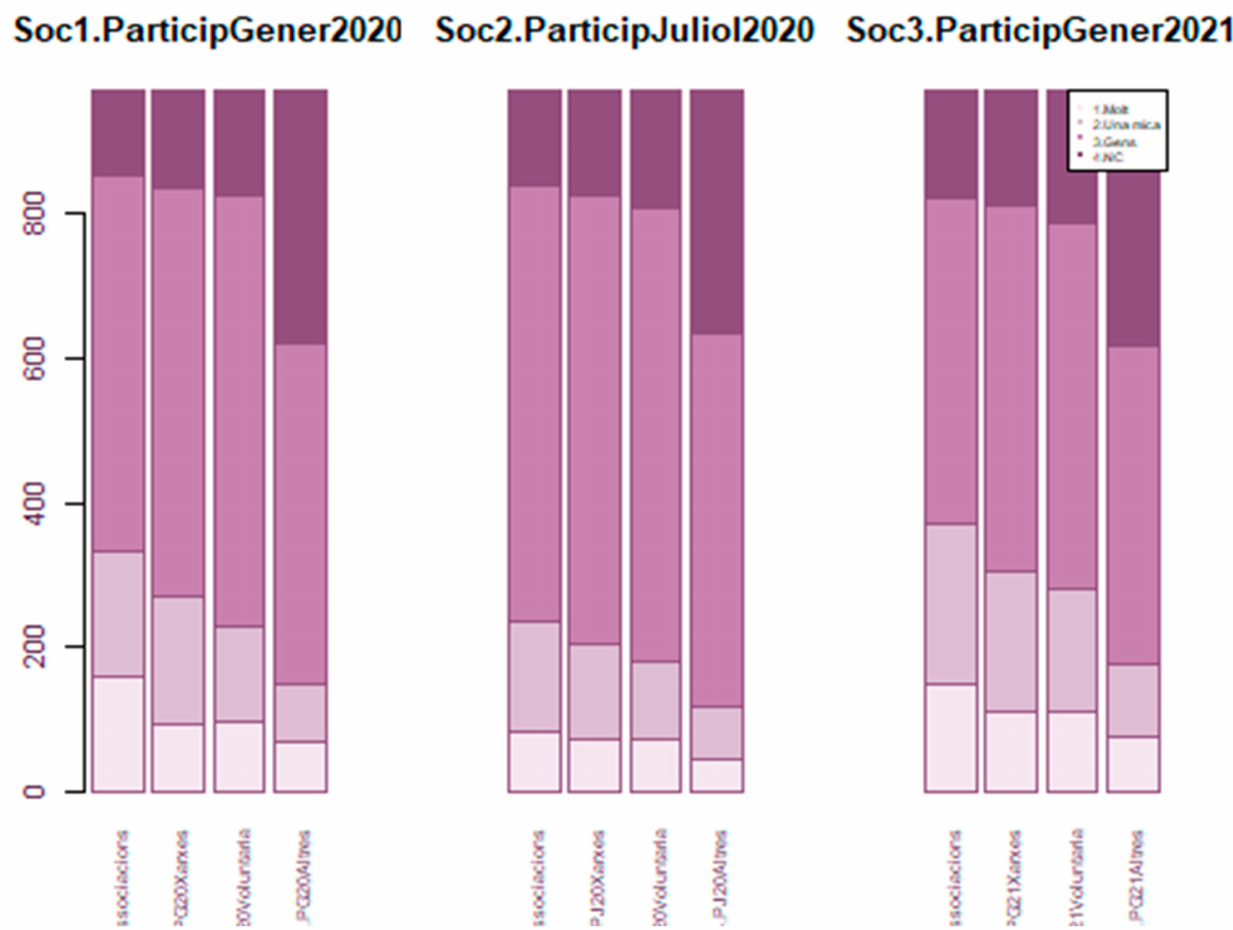
Figure 15. Multiple stacked plot o Question Soc1-2-3. From left to right the vertical labels are: Soc1.1.PG20Associacions (participation in associations in January 2020); Soc1.2.PG20 Xarxes; Soc1.3.PG20Voluntaria; Soc1.4.PG20Altres and so